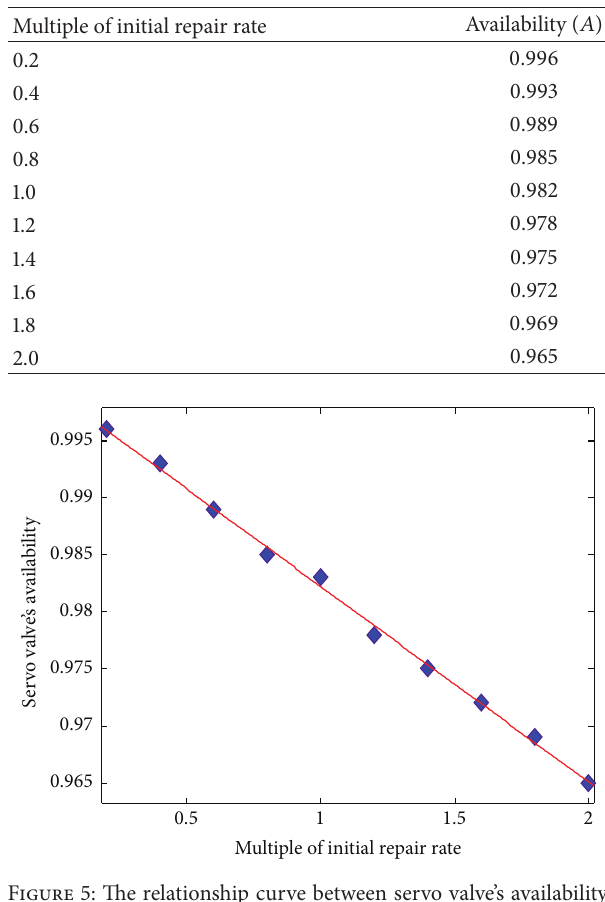
Table 4: The relationship between servo valve’s availability and multiple of initial repair rate.